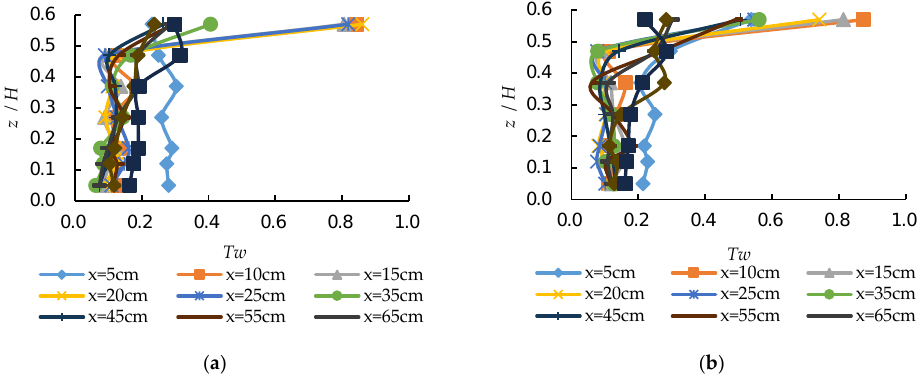
= 20.79 L / s; ( b ) Q = 30.04 L / 1 2